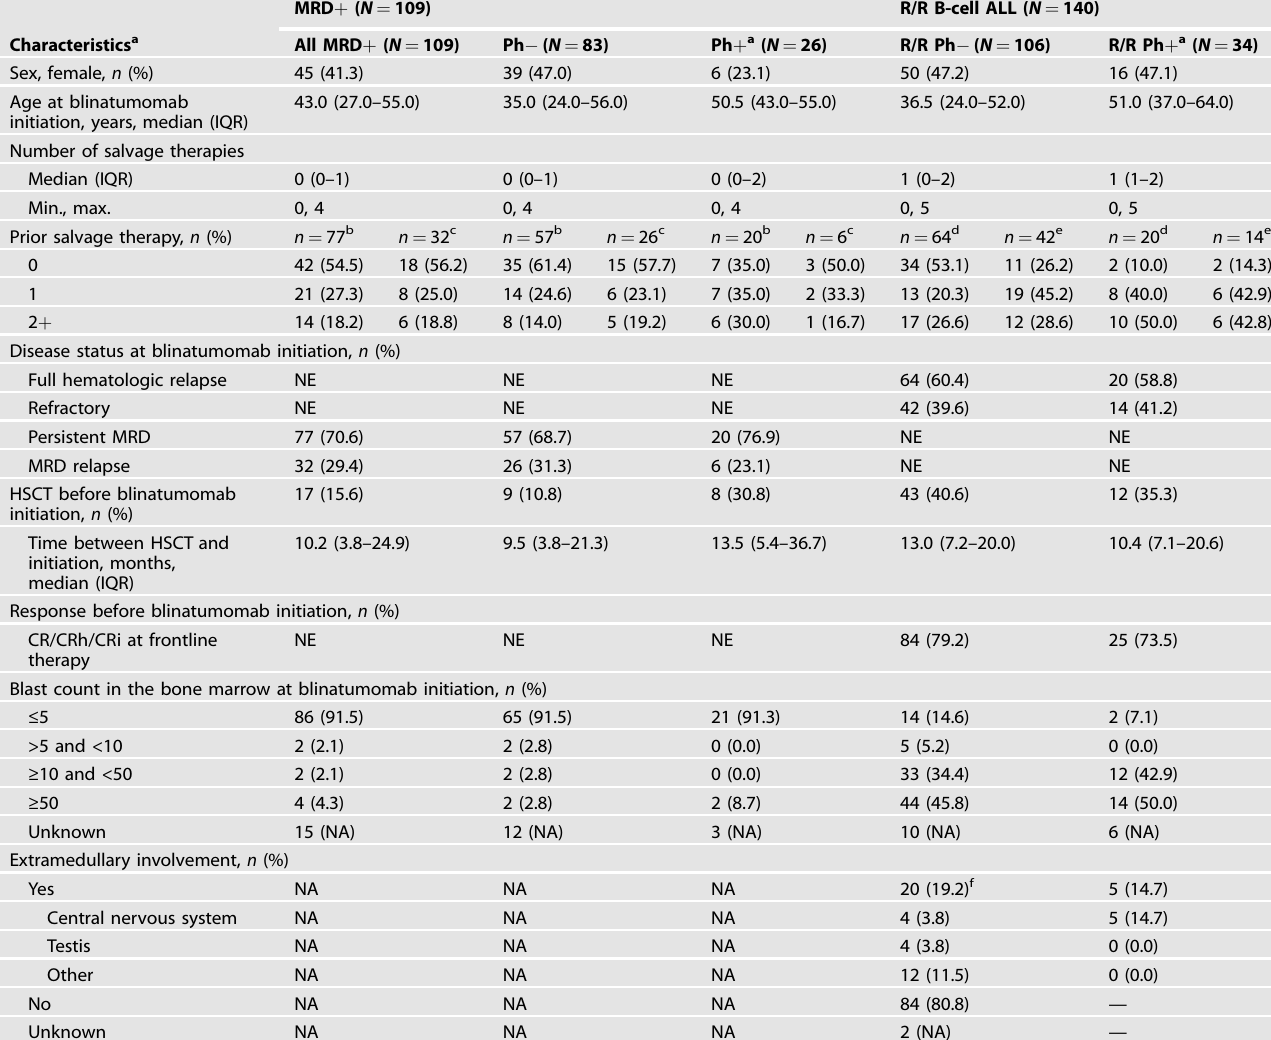
Unknown NA NA NA 2 (NA) — a Cytogenetics of patients with Ph + B-cell ALL are presented in Supplementary Table 1. b For the subset of patients who have persistent MRD. c For the subset of patients who are in MRD relapse. d For the subset of patients who are relapsed. e For the subset of patients who are refractory. f Response to blinatumomab was examined in a subgroup of patients with extramedullary involvement. B-cell ALL B-cell acute lymphoblastic leukemia, CR complete remission with full recovery of peripheral blood counts, CRh complete remission with partial recovery of peripheral blood counts, CRi complete remission with incomplete recovery of peripheral blood counts, HSCT hematopoietic stem cell transplantation, IQR interquartile range, max . maximum, min . minimum, MRD minimal residual disease, MRD + MRD-positive, NA not applicable, NE not estimated, Ph − Philadelphia chromosome-negative, Ph + Philadelphia chromosome-positive, R/R